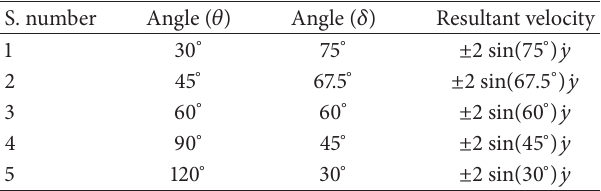
Table 3: Relation between angles 𝜃 and 𝛿